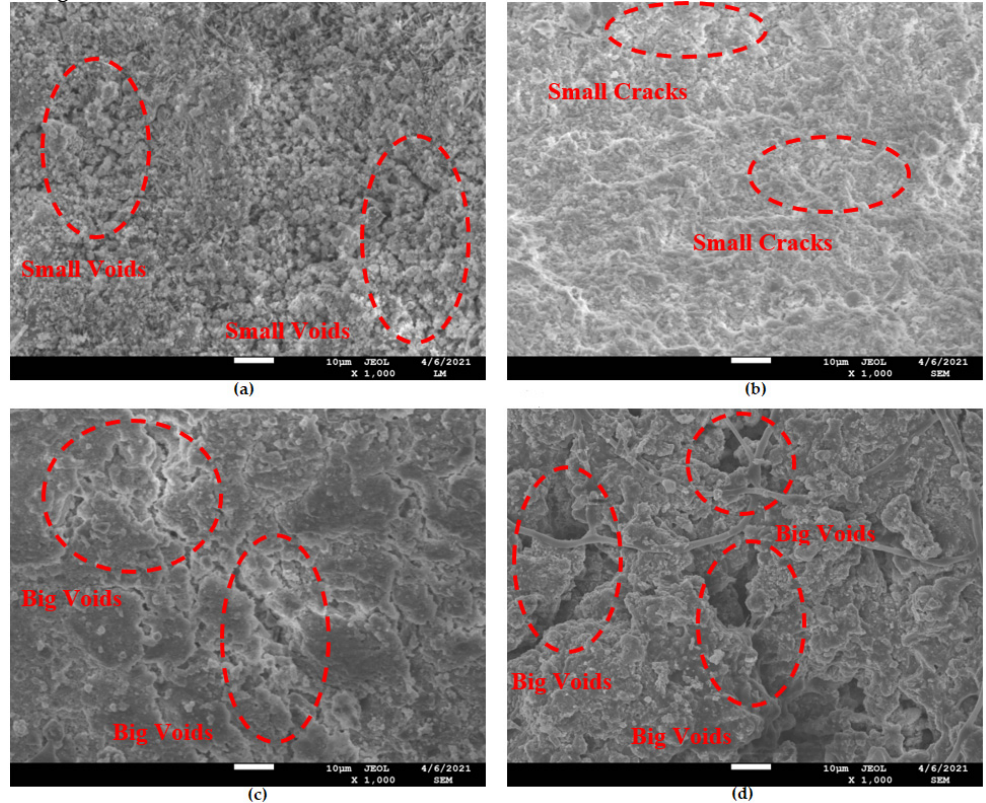
Figure 10. SEM images of HBSAC cement paste and OPC cement paste at 1 day and 28 days of age: ( a ) HBSAC 1 d, ( b ) HBSAC 28 d, ( c ) OPC 3 d, and ( d ) OPC 28 d.